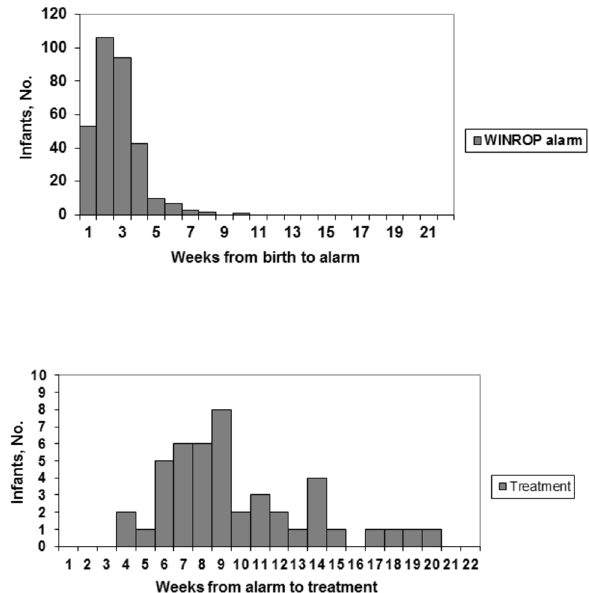
Figure 3. Time from birth to the WINROP alarm (A) and time from the alarm to treatment (infants with ROP type 1)